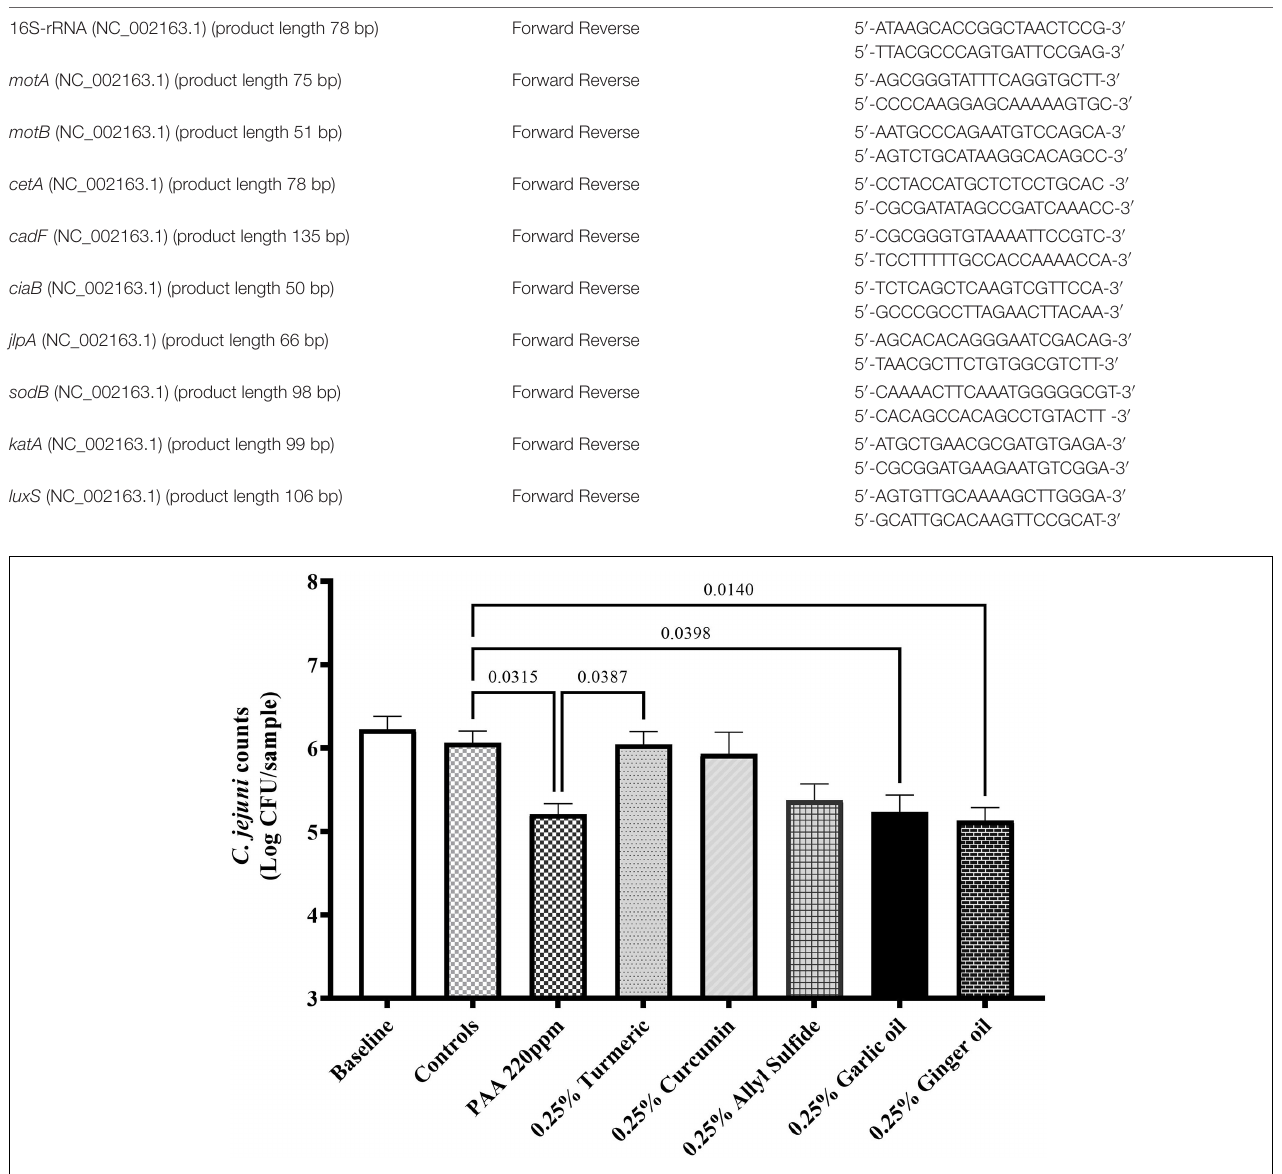
FIGURE 1 | Antimicrobial efficacy of phytochemicals as chill tank treatment at 0.25% dose in reducing Campylobacter jejuni strain S-8 on chicken skin. Chicken skin samples were inoculated with 7.2 Log CFU/sample of C. jejuni . Results are averages of two independent trials, each containing triplicate samples (mean and SEM). The estimated p -values < 0.05 are included above the